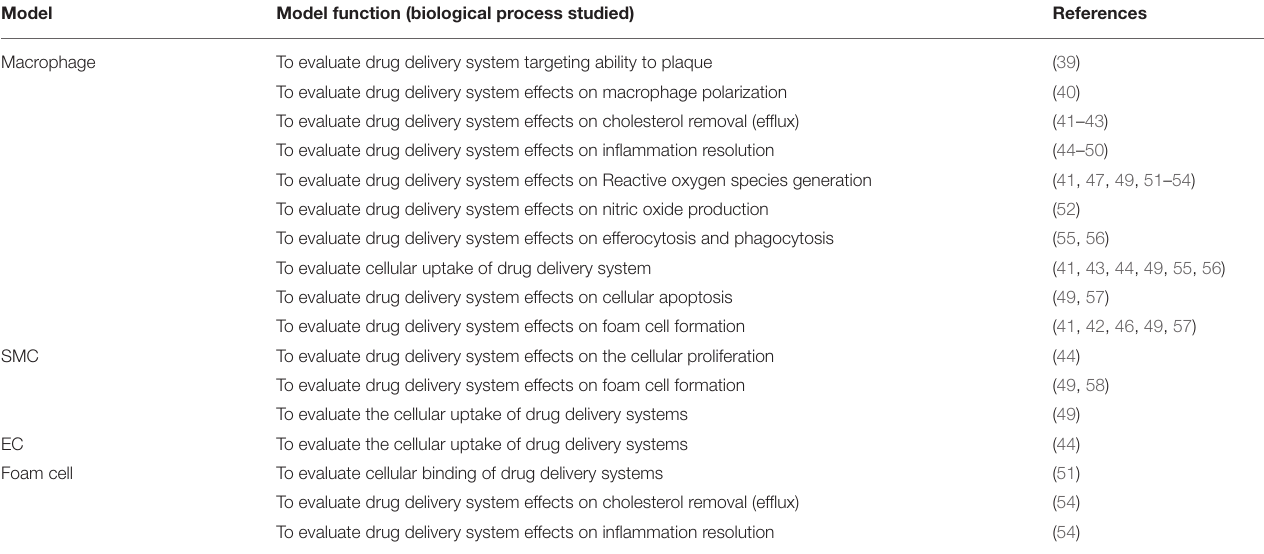
TABLE 1 | Summary of in vitro 2D single-cell culture model and its specific function for evaluating drug delivery system for atherosclerosis.